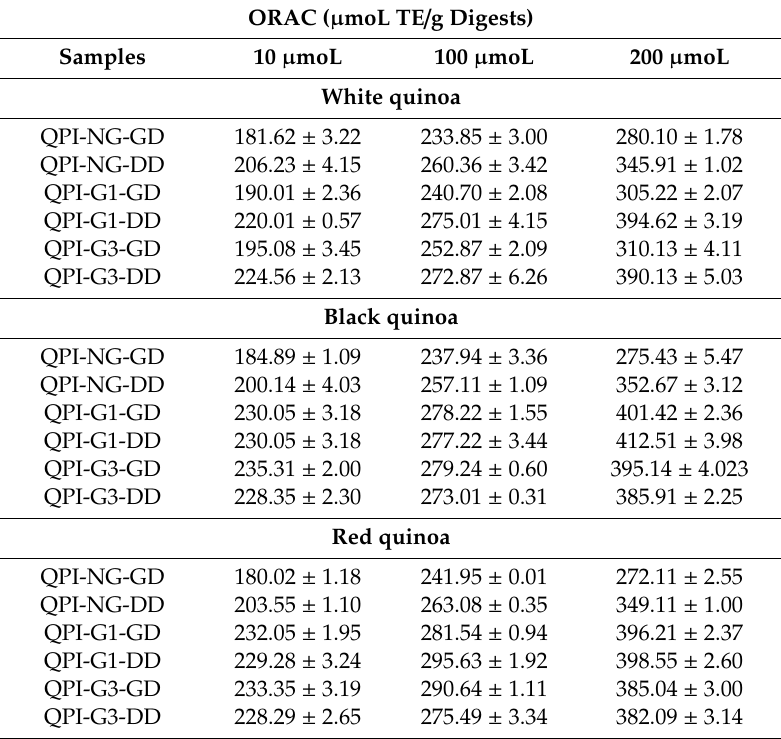
Table 4. Antioxidant activity of QPIs digest of non-germinated and germinated white, red and black quinoas using the ORAC